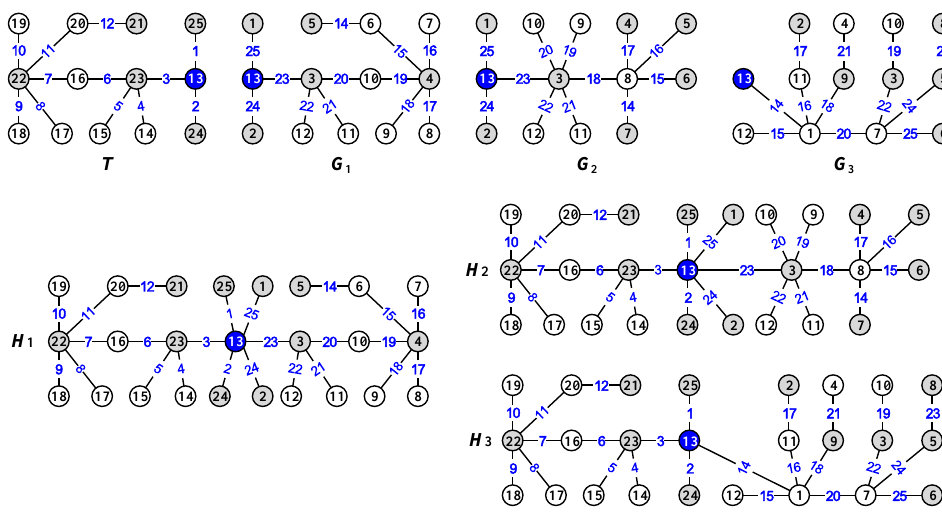
Figure 2. Examples The graphs T , G 1 , G 2 , G 3 for illustrating the 6C-labeling defined in Definition 2, the graphs TH 1 , H 2 , H 3 reciprocal-inverse labeling defined in Definition 3, and the 6C-complimentary matching defined in Definition